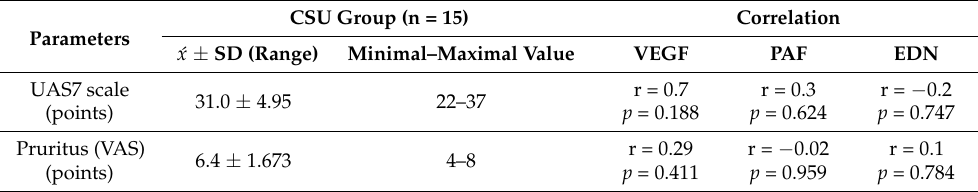
Table 2. Clinical characteristic of the examined patients with chronic spontaneous